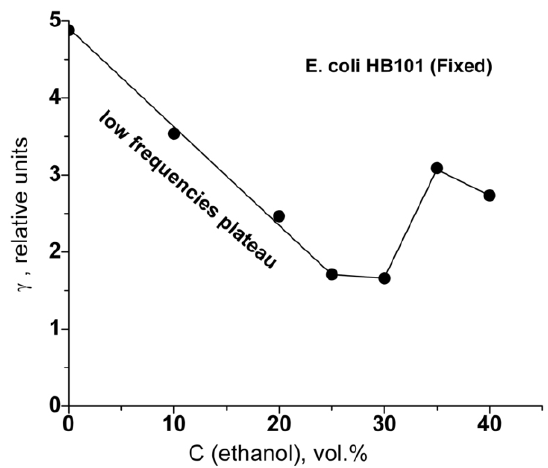
Figure 5. The dependence of the polarizability ( γ ) of E. coli HB101 (fixed) cells on the concentration of ethanol at low frequencies.